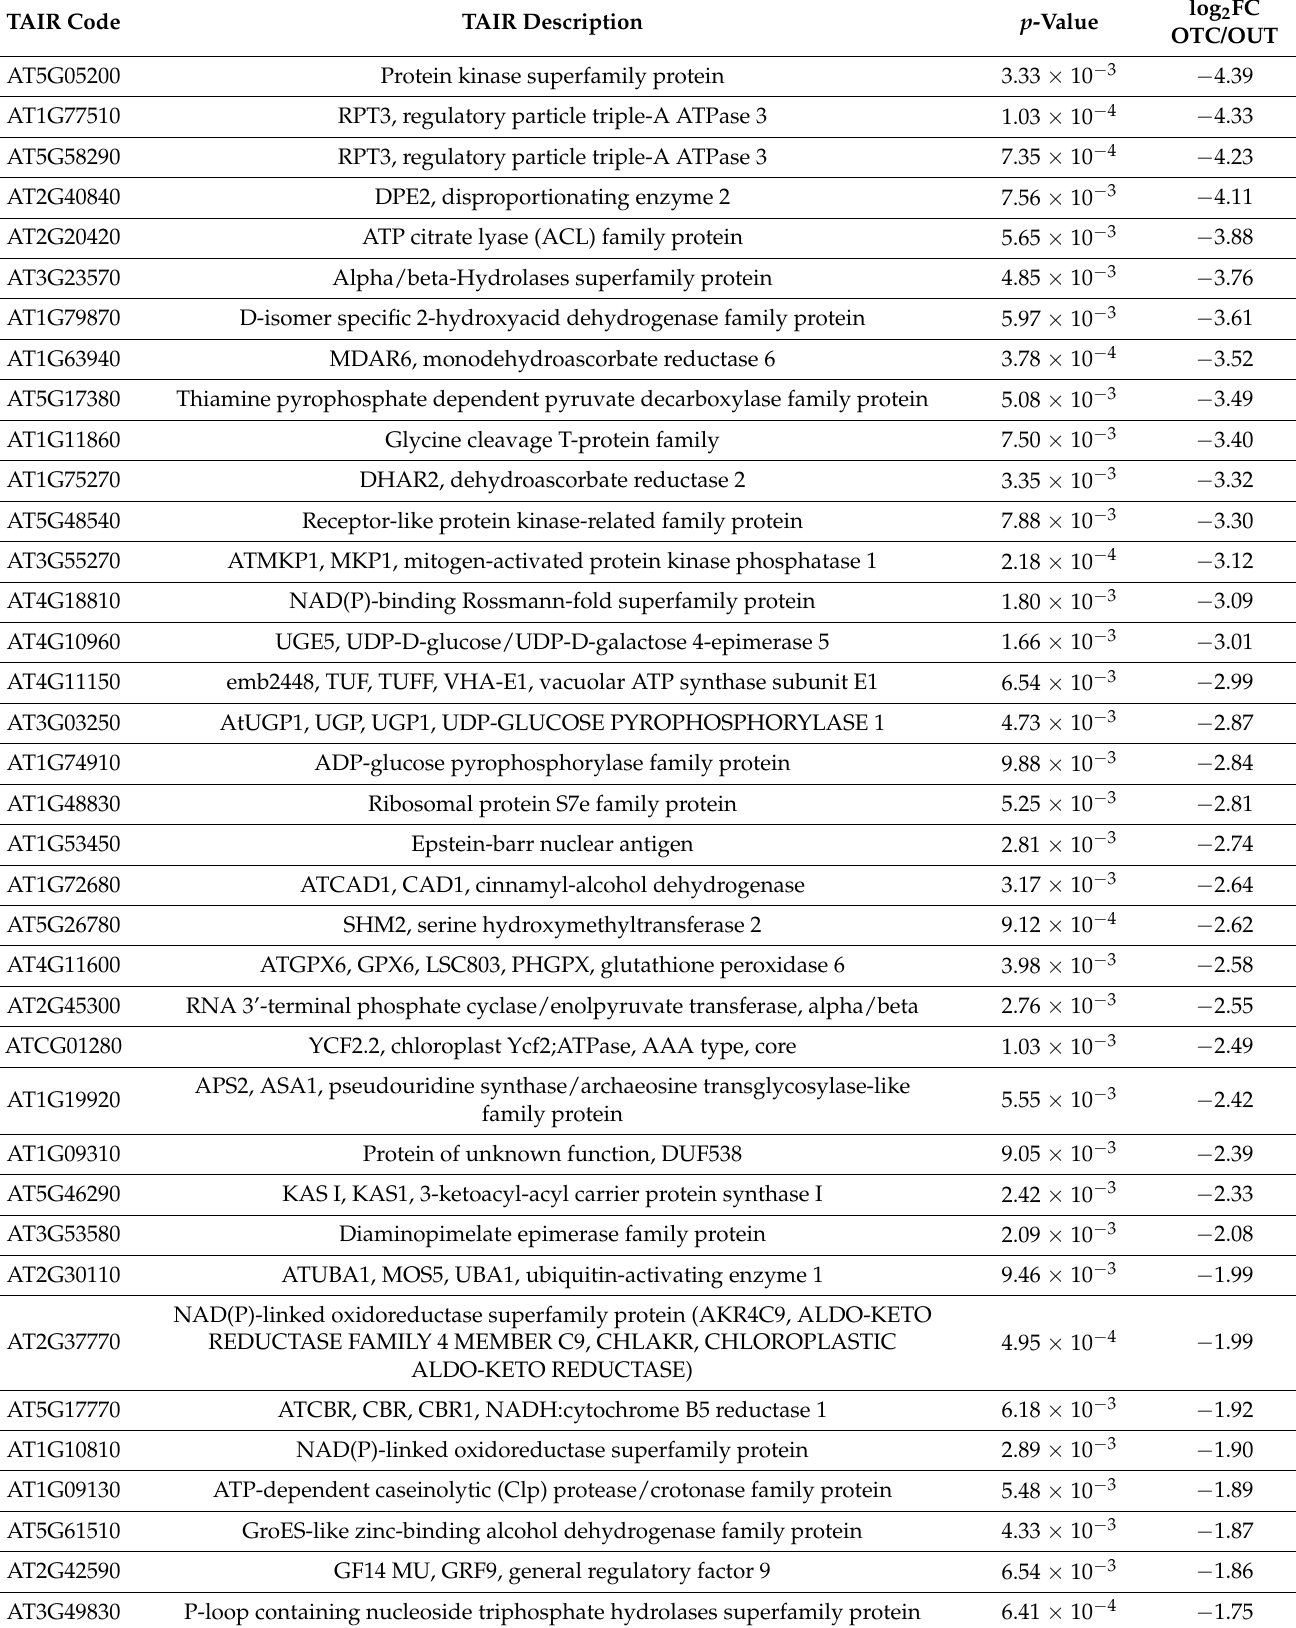
Table 2. List of the 52 downregulated